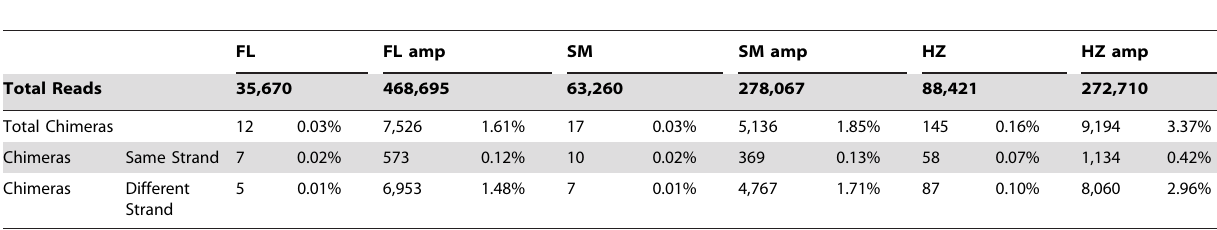
Table 2. Chimeric sequence statistics for amplified and nonamplified DNA.